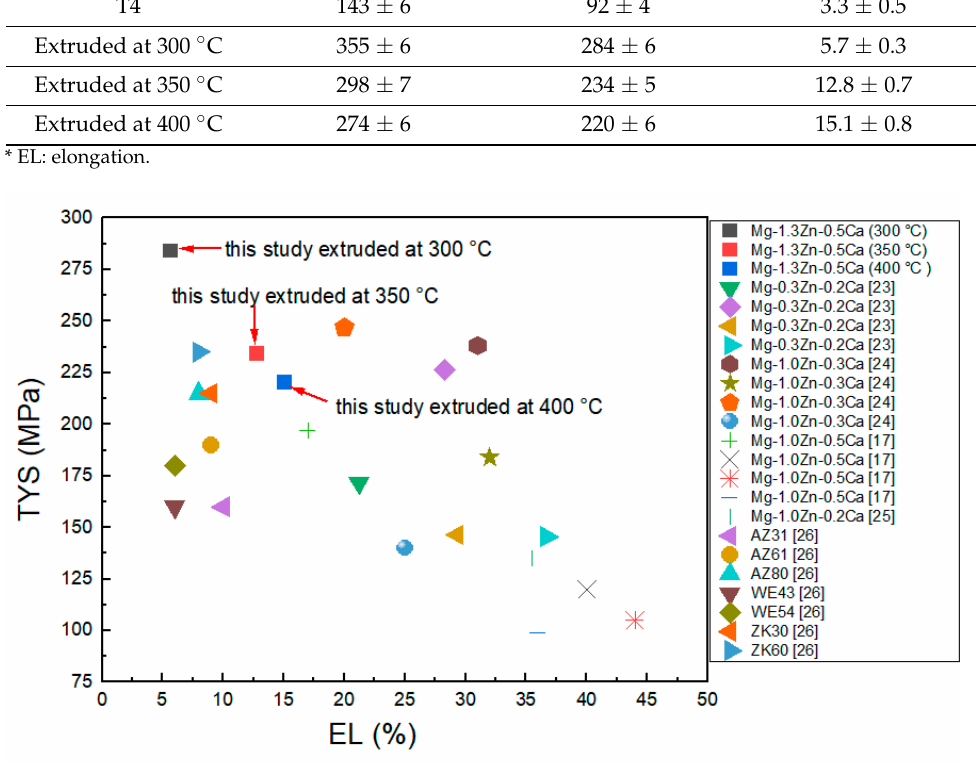
Figure 11. The comparison of tensile yield strength (TYS) among the present ZX10 alloy